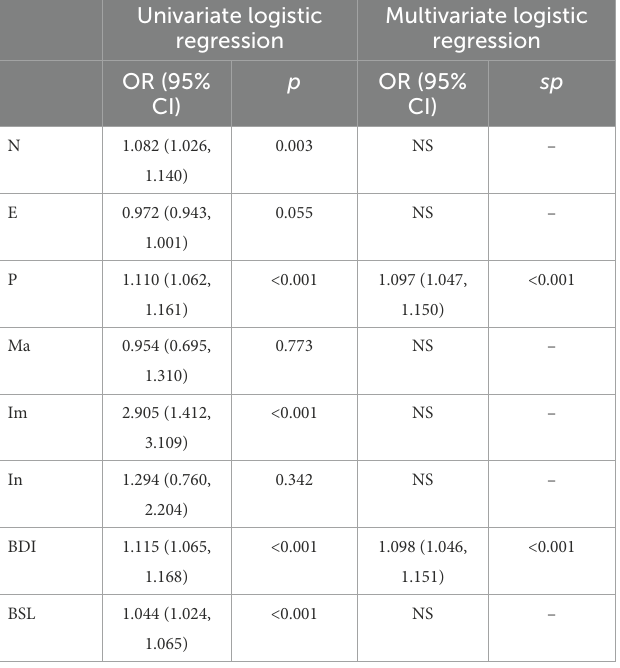
TABLE 4 Results of univaraiate and multivariate logisctic regression analysis for NSSI. Univariate logistic